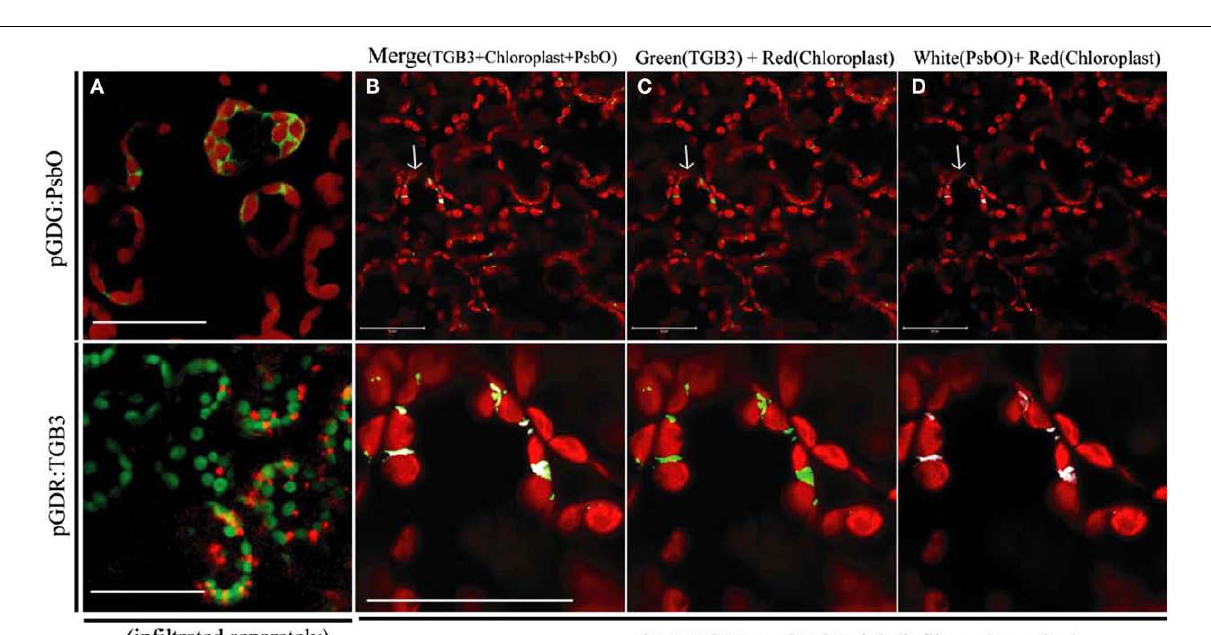
FIGURE 3 | Interaction between GFP:PsbO (NbPsbO) and DsRed:TGB3 in mesophyll tissue of Nicotiana benthamiana . Constructs pGDG:PsbO and pGDR:TGB3 were infiltrated separately (A) , or co-agroinfiltrated (B–D) into leaves of N. benthamiana and examined by LSCM at 3dpa. (A) Upper, GFP:PsbO (shown as green) expressed alone, showing localization around the chloroplasts, with chloroplast autofluorescence shown in red; lower, DsRed:TGB3 (shown as red) showing punctate spots associated with chloroplasts, with chloroplast autofluorescence shown in green. (B–D) The